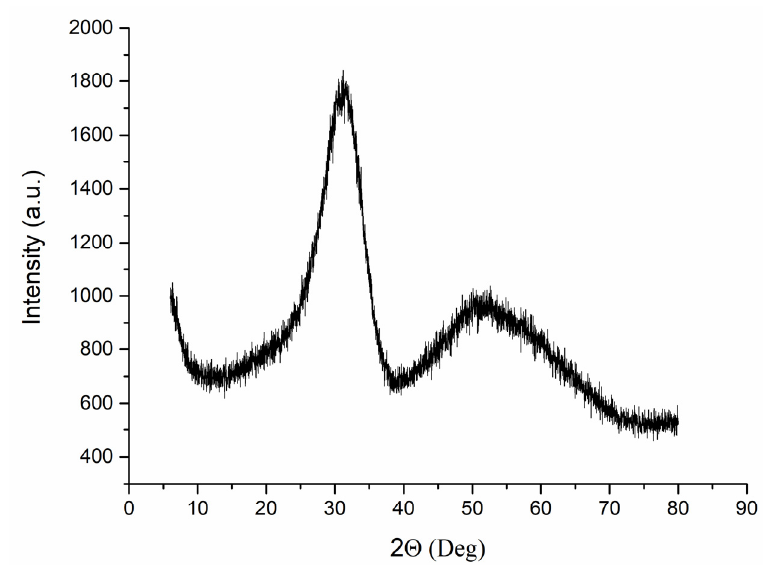
Figure 1. XRD pattern of the amorphous YSZ nanopowder after synthesis.